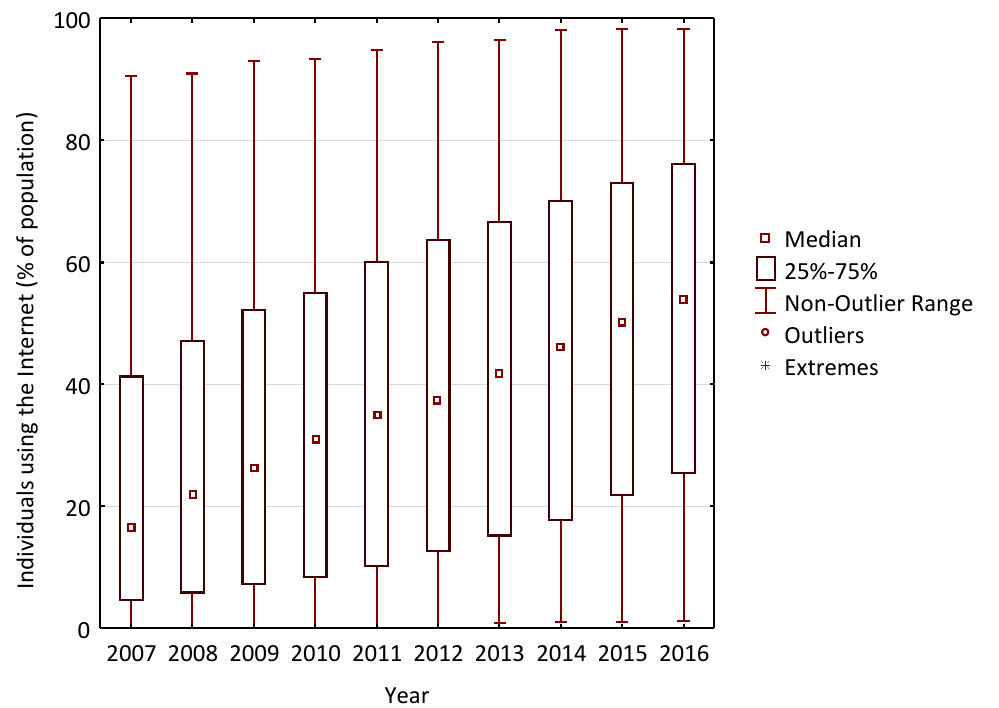
Source: The World Bank Group